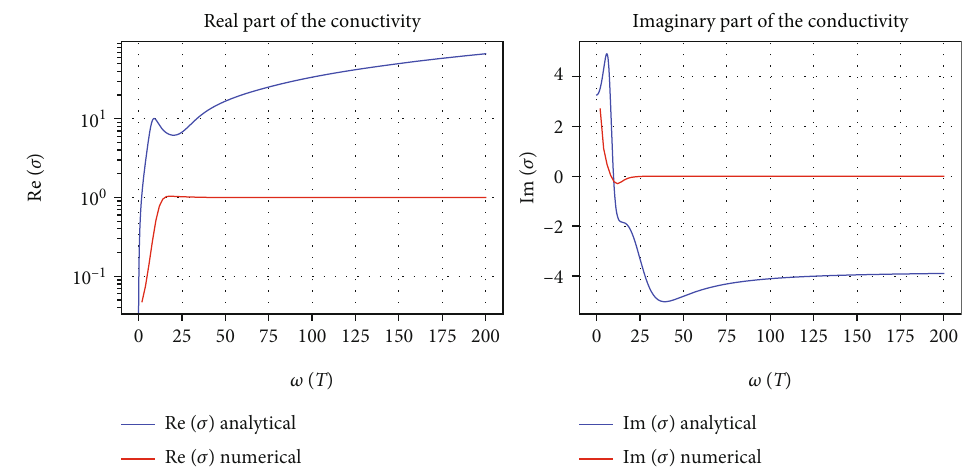
Figure 6: Critical temperature in Kelvin for s-, p-, d-, f-, and g-wave superconductors as a function of h ′ ð 1 Þ for h ð 1 Þ = 3 and all masses chosen at the respective BF bound, Equation (38). The energy density of the gauge fi eld ϕ near the horizon has been set to ρ = 7 : 5 · 10 − 3 eV 2 so as to relate the prediction of the model with physical systems. The dashed blue vertical line emphasises the AdS Schwarzschild BH case h ′ ð 1 Þ = − 3